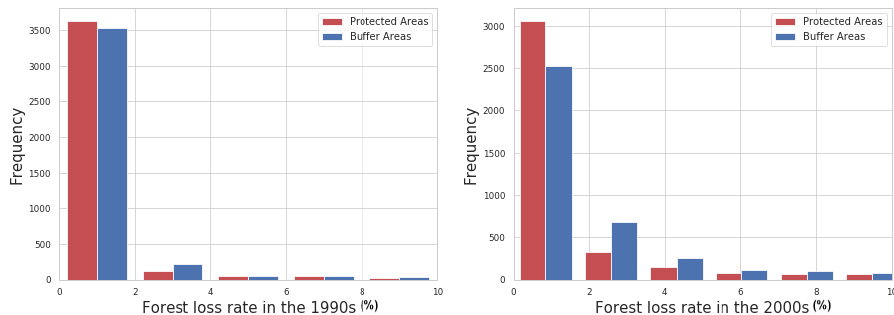
Figure 4. Frequency distribution of the difference in forest loss rates between the interior of protected areas and the surrounding 10 km buffers in the 1990s ( left ) and the 2000s ( right ).